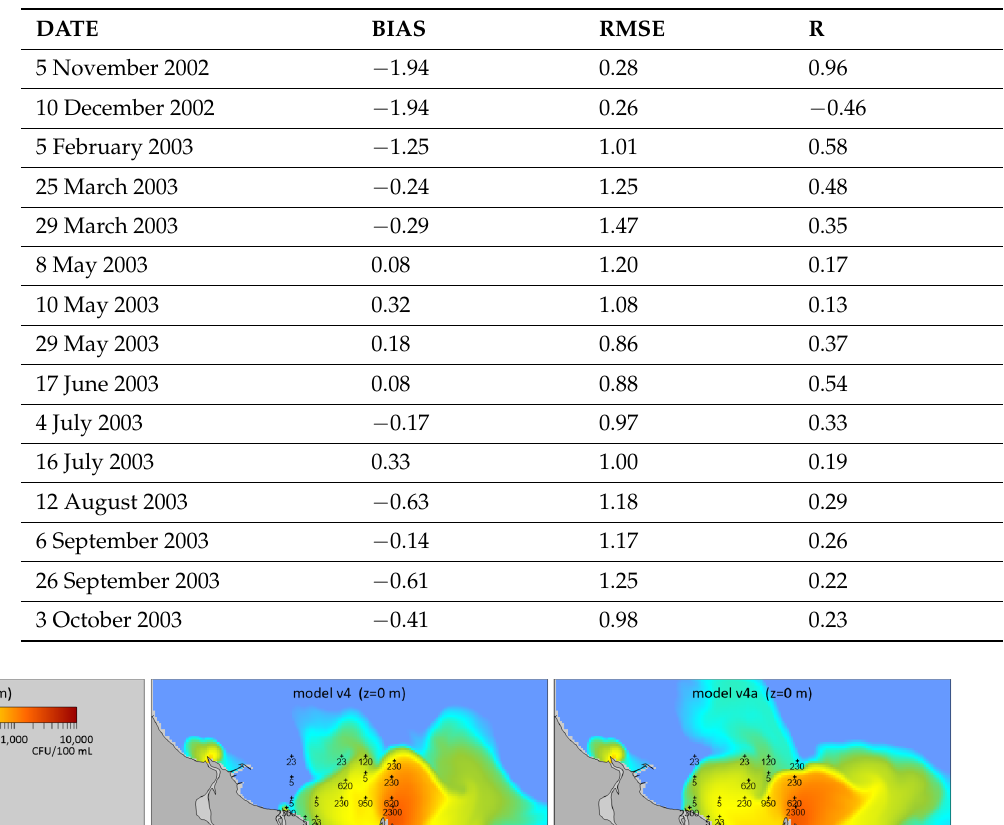
Table 1. Statistical compliance characteristics of the observed and modeled decimal logarithms of E. coli concentrations in the surface waters of the Gulf of Gda´nsk in the period from November 2002 to October 2003.